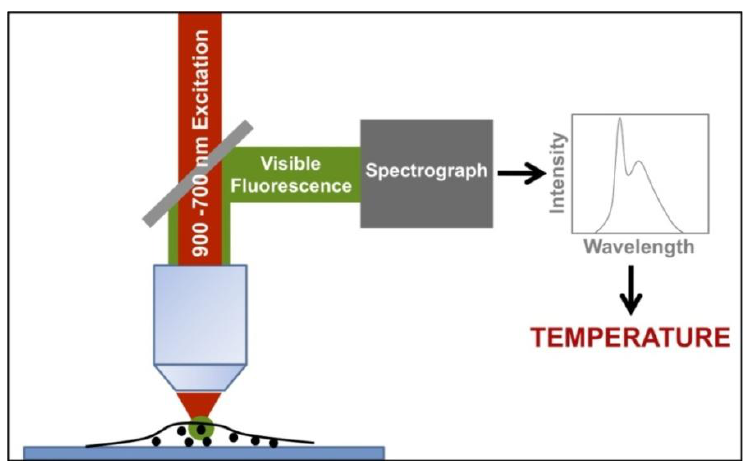
Figure 21. Typical experimental arrangement for measuring intracellular temperatures by means of two-photon excited fluorescent